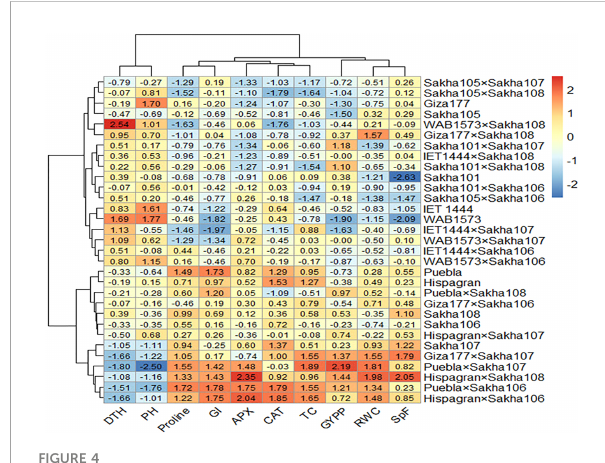
FIGURE 4 Heatmap showing the relationship between genotypes and the studied traits under water de fi cit conditions based on standardized